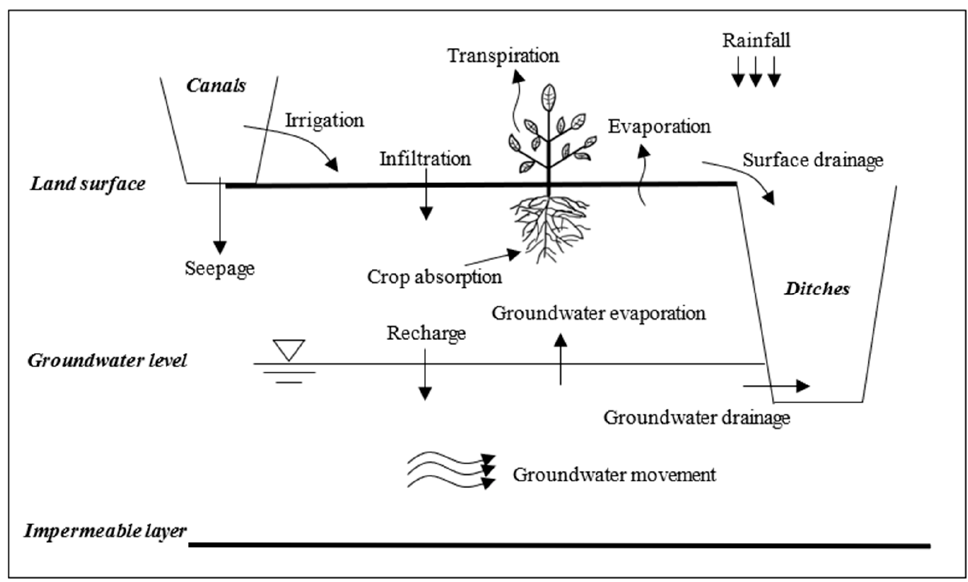
Figure 1. Water interactions among surface water and subsurface water in irrigation districts.